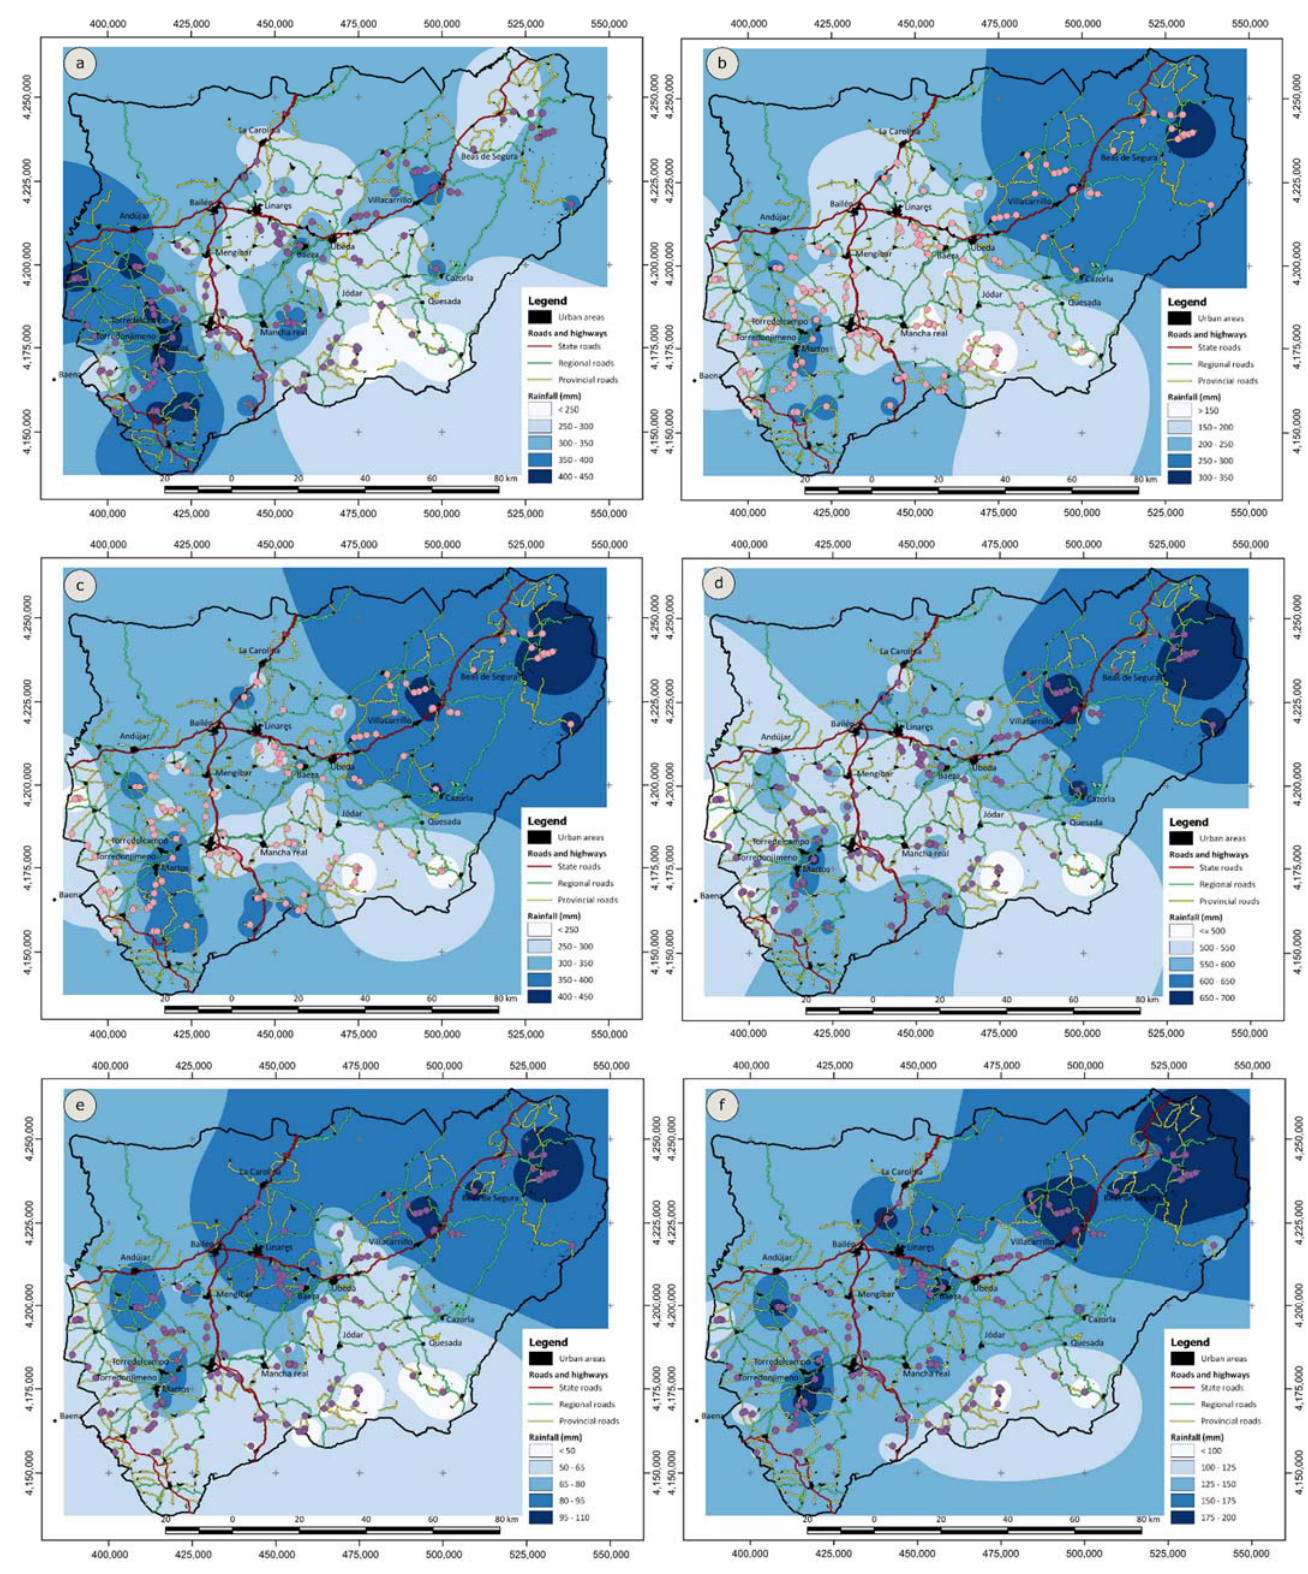
Figure 6. Isohyets maps of some events: ( a ) 31/12/1997 (D = 60 days); ( b ) 30/12/2009 (D = 15 days); ( c ) 13/01/2010 (D = 30 days); ( d ) 22/02/2010 (D = 75 days); ( e ) 03/11/2012 (D = 2 days); and ( f ) 08/11/2012 (D = 7 days).